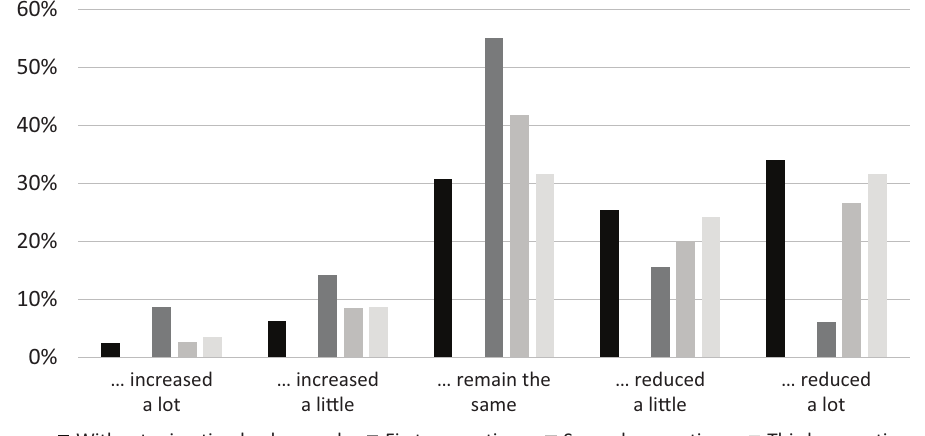
Figure 1. Attitudes towards immigration by migrant generation in percentage